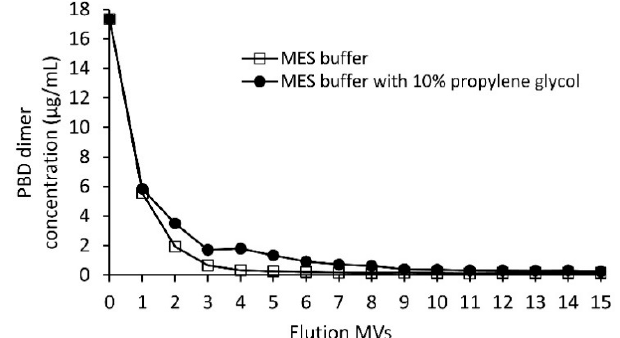
Figure 2. The Sartobind ® S clearance trend of the linker-PBD using 20 mM MES buffer at pH 6.0 with and without 10% propylene glycol. The linker-PBD concentration from each eluted MVs was quantified with the LC-MS/MS method as described in the Materials and Methods section.